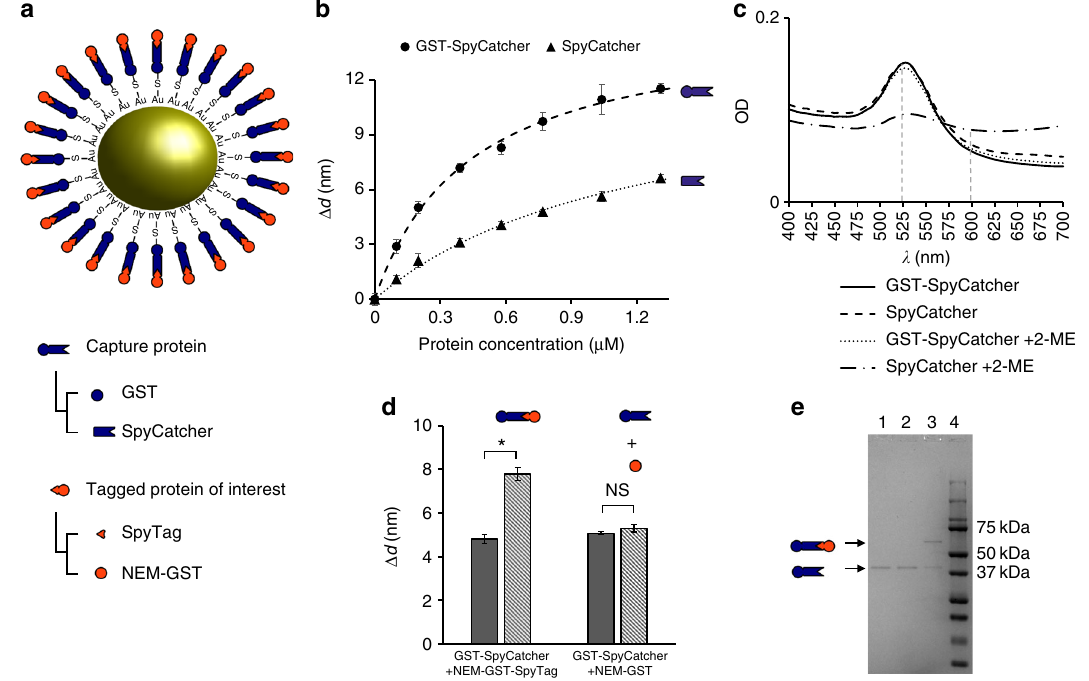
Fig. 4 Hierarchical assembly of GST-SpyCatcher and SpyTag on GNPs. a Design of the conjugation strategy. Blue identi fi es the fi rst layer of proteins, orange highlights the second layer. Figure is not to scale. b Equilibrium binding data of GST-SpyCatcher compared to SpyCatcher without GST. The fi t to the binding model shows that GST fusion improves binding of SpyCatcher to GNPs. Data points and error bars represent average and standard deviation of three measurements respectively. c Comparison of UV – vis spectra of GNPs coated with GST-SpyCatcher or SpyCatcher before and after adding 2-ME. Whereas SpyCatcher/GNPs are destabilized by 2-ME, GST-SpyCatcher/GNPs are stable, suggesting formation of Au – S bonds. Vertical dashed lines indicate the two wavelengths previously used for calculations of the Au – S index and highlight a sharp decrease of the SPR peak at 525 nm in absence of GST. d Δ d of GST-SpyCatcher/GNPs before (dark gray) and after (light gray) addition of either NEM-GST-SpyTag (left) or untagged NEM-GST (right). Tagging NEM-GST with SpyTag results in a signi fi cant increase of Δ d , suggesting that a second layer of protein extensively binds to GNPs. Δ d are averaged over three measurements with error bars representing standard deviation. t -test results with a 95% con fi dence interval are indicated by asterisk (signi fi cant, p = 0.0001) and NS (non-signi fi cant, p = 0.0991). e SDS-PAGE of proteins bound to GNPs. Lane 1: GST-SpyCatcher/GNPs before any further incubation; lane 2: GST-SpyCatcher/GNPs incubated with untagged NEM-GST; lane 3: GST-SpyCatcher/GNPs incubated with NEM-GST-SpyTag; lane 4: protein marker (relevant molecular weights are reported on the right). A band corresponding to GST-SpyCatcher-NEM-GST-SpyTag appears in lane 3, suggesting formation of the isopeptide bond between the two layers of protein